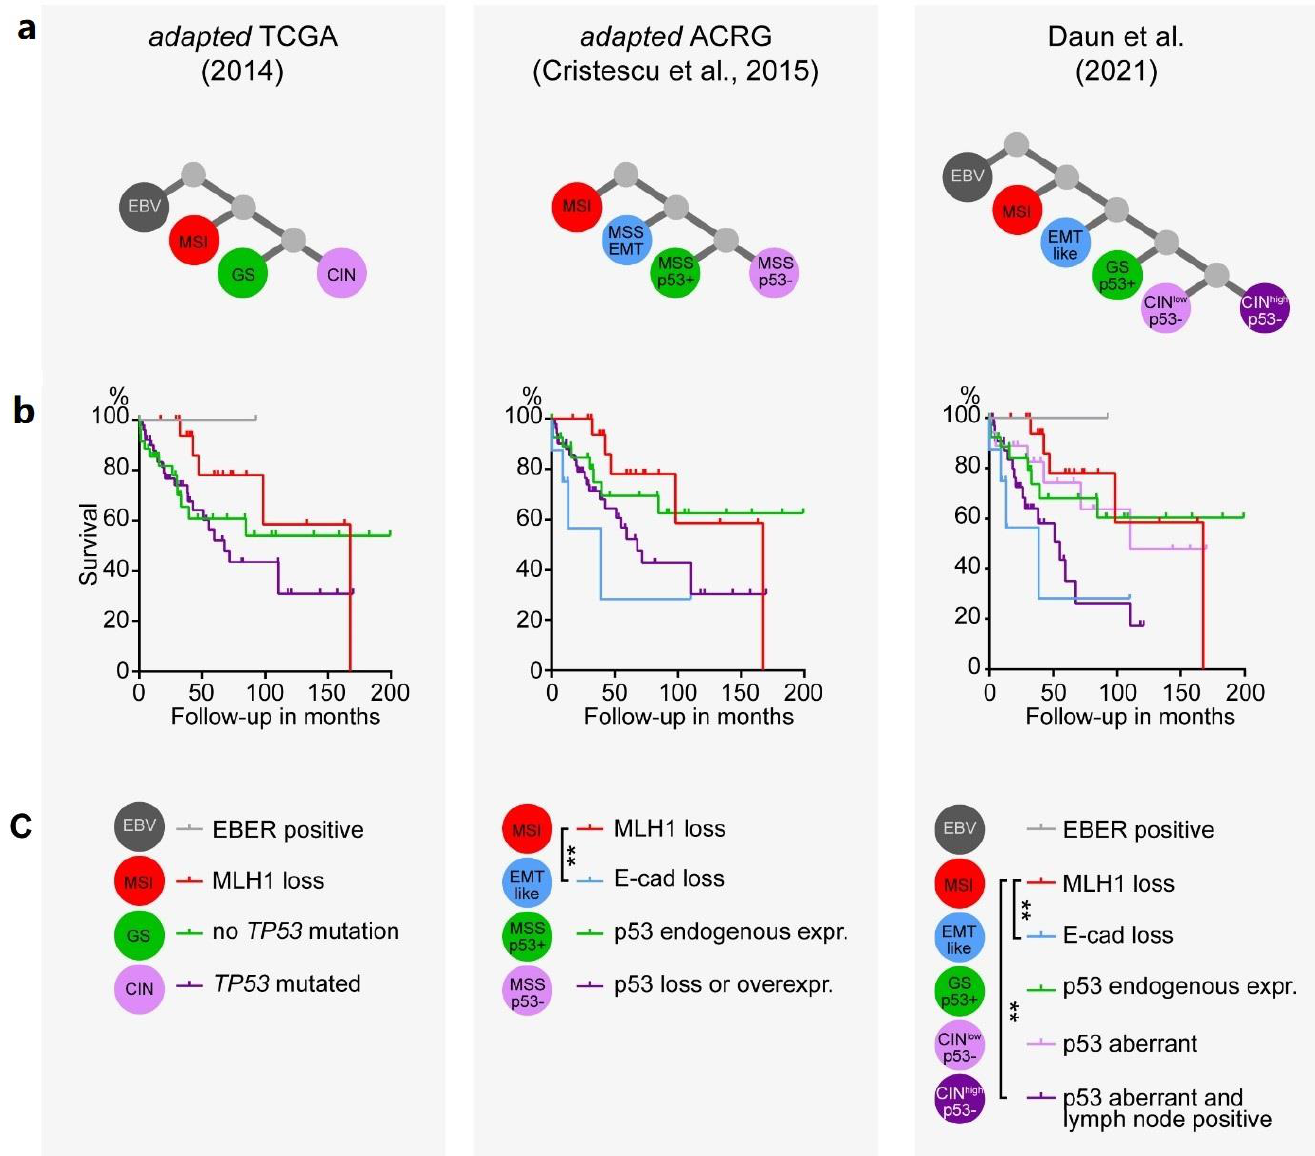
Figure 5. Association of survival and the two major molecular classifications of gastric adenocarcinoma, the TCGA and ACRG and the workflow described in this work, using the data of this study. ( a ) Schematic of the algorithm applied and ( b ) Kaplan – Meier survival curves with ( c ) legend listing subtype-defining markers and statistical significances calculated by pairwise group comparison with the Mantel – Cox log-rank test. Asterisks depict magnitude of statistical significance: **, p < 0.01.